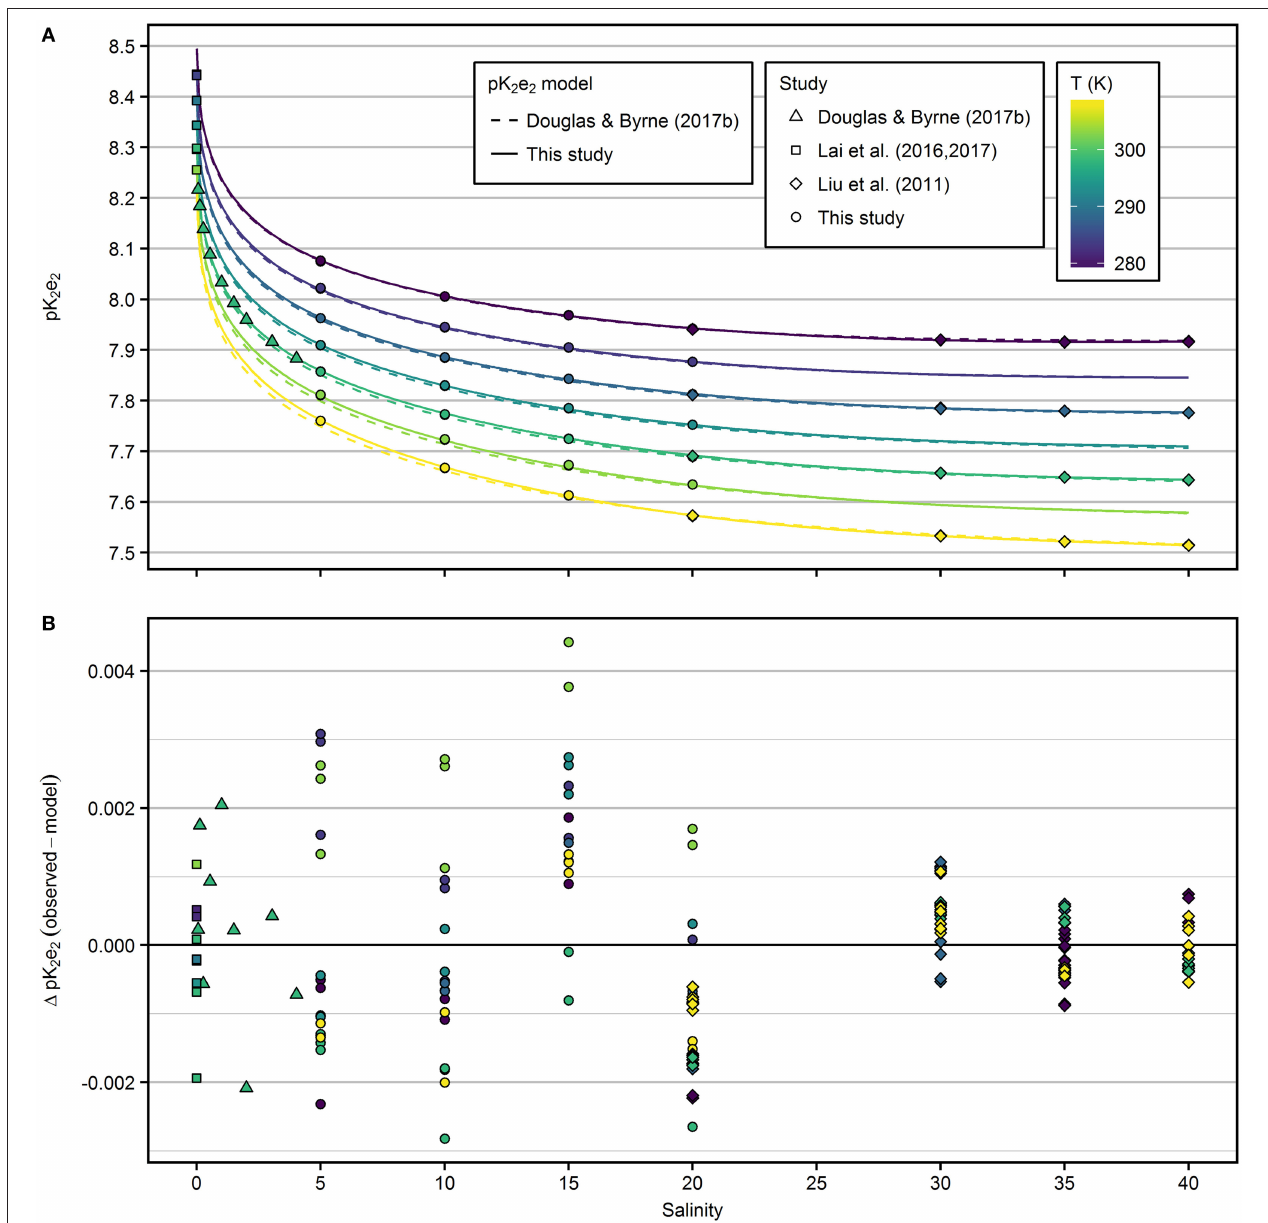
FIGURE 2 | (A) pK 2 e 2 of mCP as a function of salinity and temperature. Results from this study (salinity range 5–20) were combined with previous results and fitted to a common pK 2 e 2 model (solid lines). Dashed lines represent the pK 2 e 2 model by Douglas and Byrne (2017b). (B) Residuals from the model fitted in this